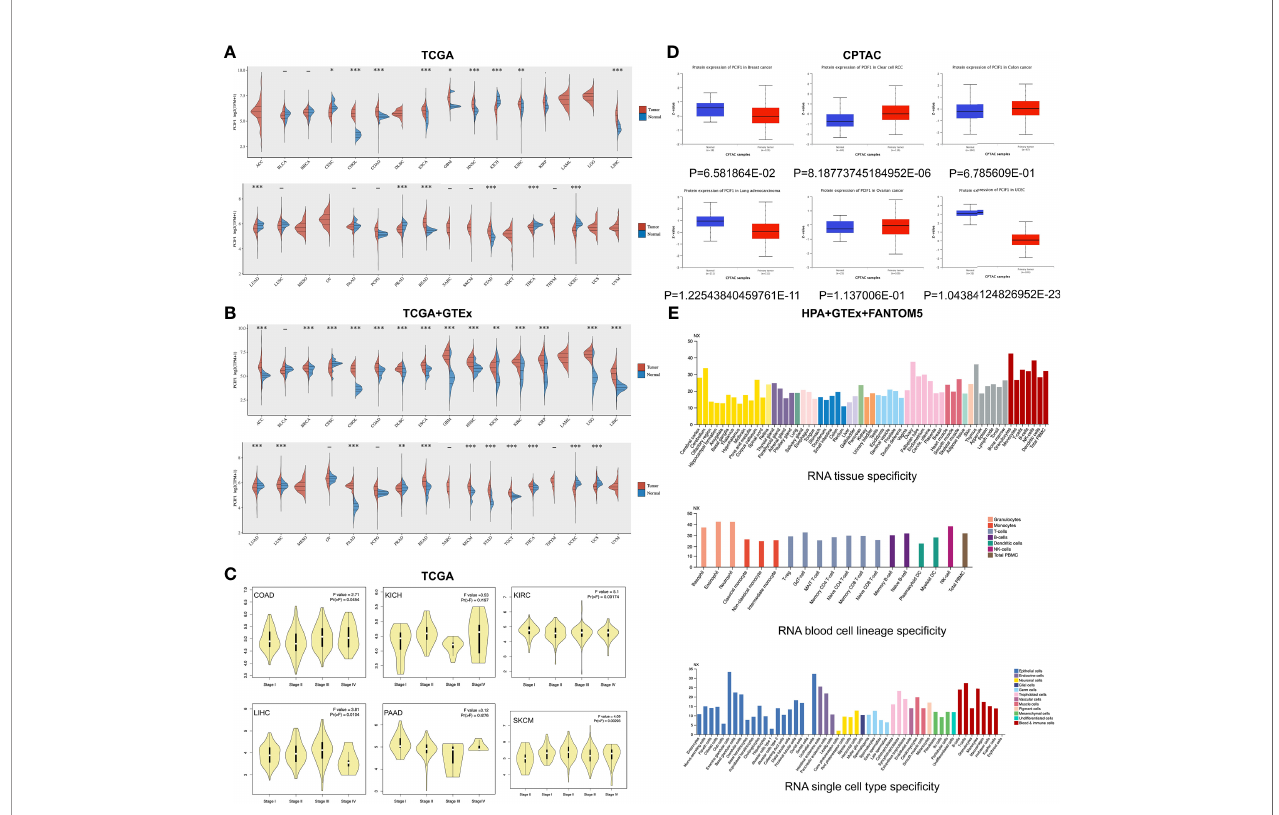
FIGURE 1 | Differential expression of PCIF1. (A) Expression of PCIF1 gene in different TCGA tumors. * p < 0.05; ** p < 0.01; *** p < 0.001. (B) For ACC, DLBC, LGG, MESO, OV, SKCM, and UCS, data of PCIF1 expression in normal tissues were obtained from GTEx databases as Supplementary Materials . ** p < 0.01; *** p < 0.001. (C) PCIF1 gene expressions of different pathological stages in COAD, KICH, KIRC, LIHC, PAAD, and SKCM. (D) Expression of PCIF1 total protein of breast cancer, clear-cell RCC, colon cancer, lung adenocarcinoma, ovarian cancer, and UCEC, collected from the CPTAC dataset. (E) PCIF1 RNA expression in different tissue, blood cell lineage, and single cell type based on consensus datasets